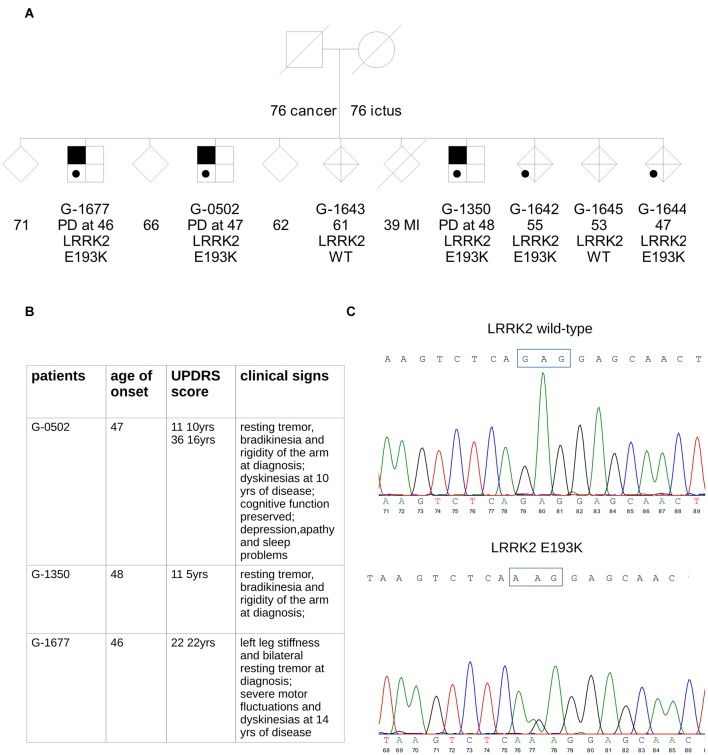
Simplified pedigree of the analyzed family. (A) Symbols with black upper corner indicate individuals affected by Parkinson’s disease (PD). Age of onset of PD (years) is reported; in the patients’ relatives, age at last examination or age at death is reported. The result of leucine-rich repeat kinase 2 (LRRK2) genetic screening for the mutation was either wild type (WT) or heterozygous carrier (E193K). Gender of healthy siblings has been masked to protect the anonymity of the families. (B) The table summarizes clinical data of the three E193K carriers. (C) Sequencing of PCR product from exon 6 of WT and mutant alleles. The upper chromatogram of the portion of the sequencing gel shows the wild allele and the lower the heterozygous mutant allele.